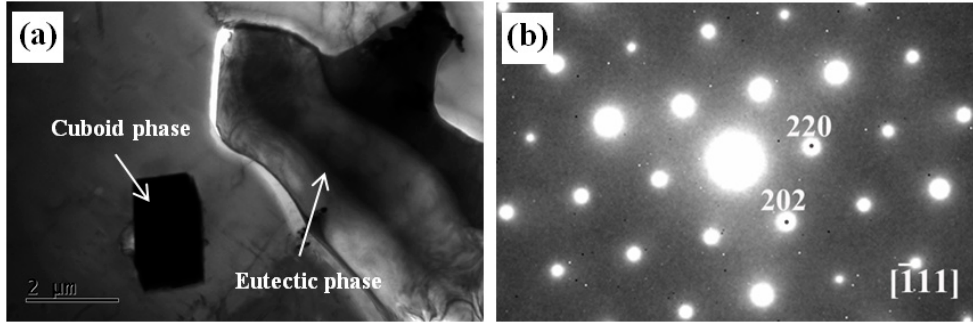
Figure 4. TEM analysis results of the as-cast 0Zn alloy: ( a ) bright field image and ( b ) selected area electron diffraction of the eutectic phase.